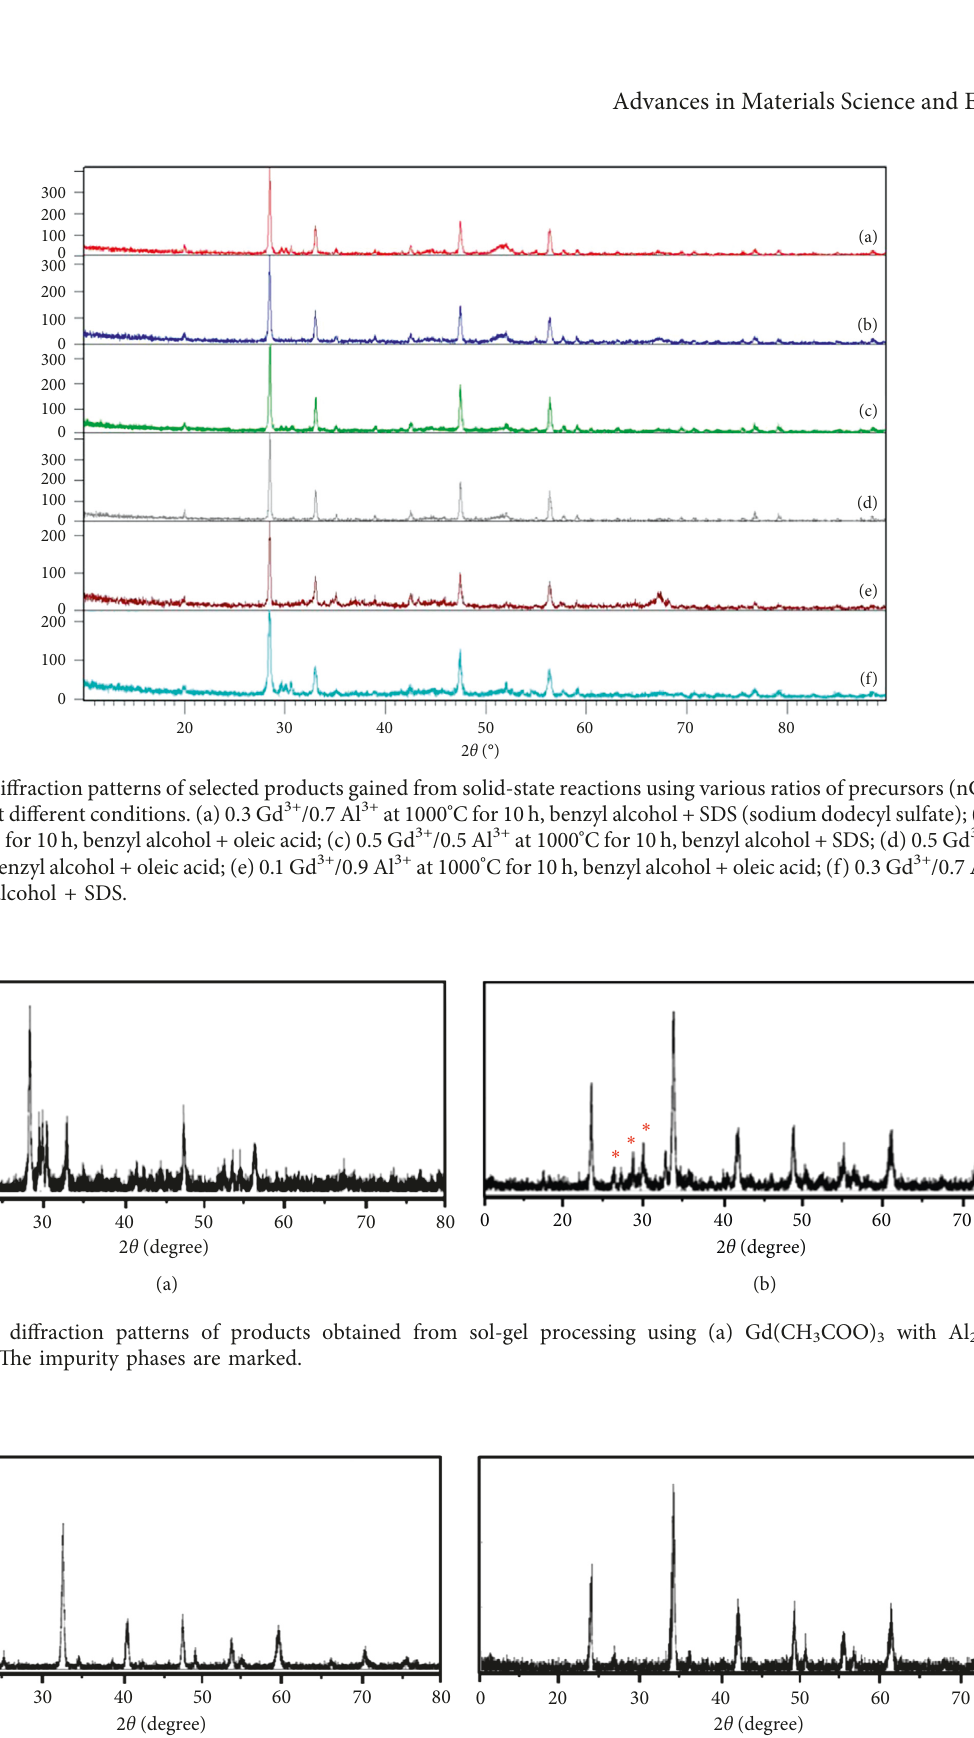
· 6H 2 O and (b) 300kGy irradiated